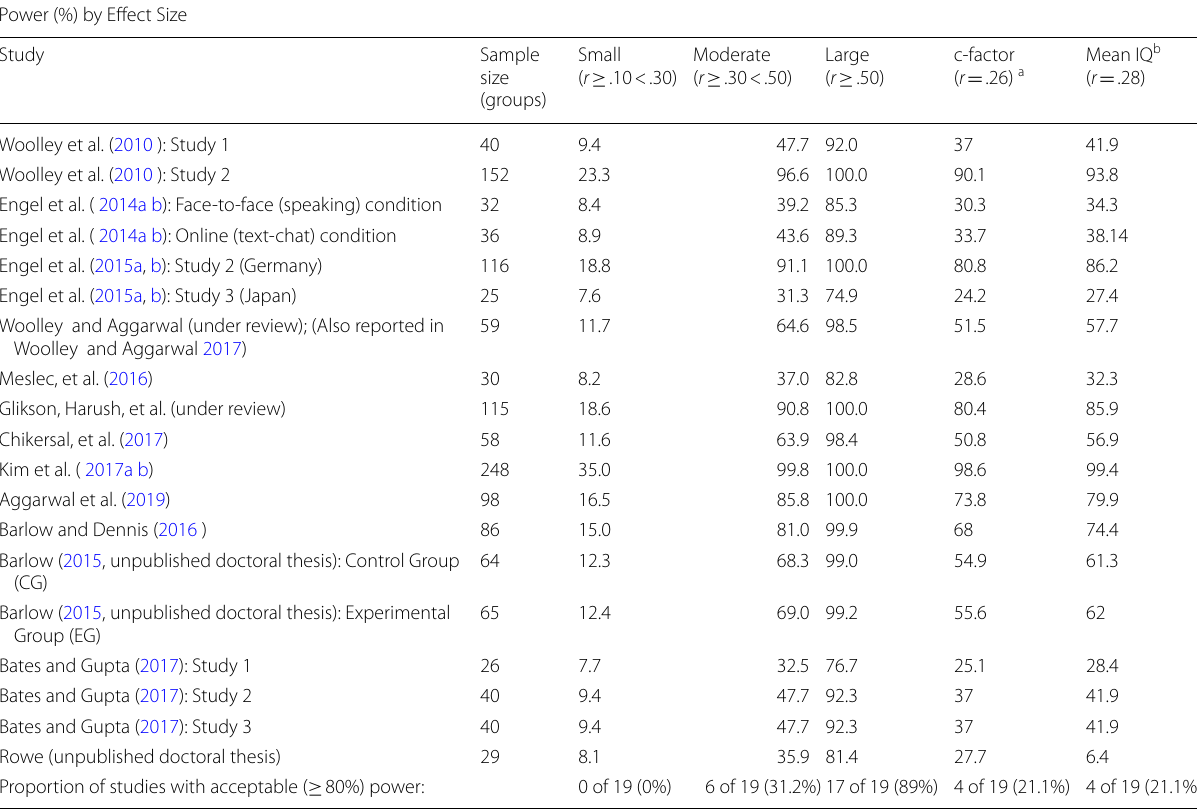
Table 5 The relationship between statistical power and observed and expected effect